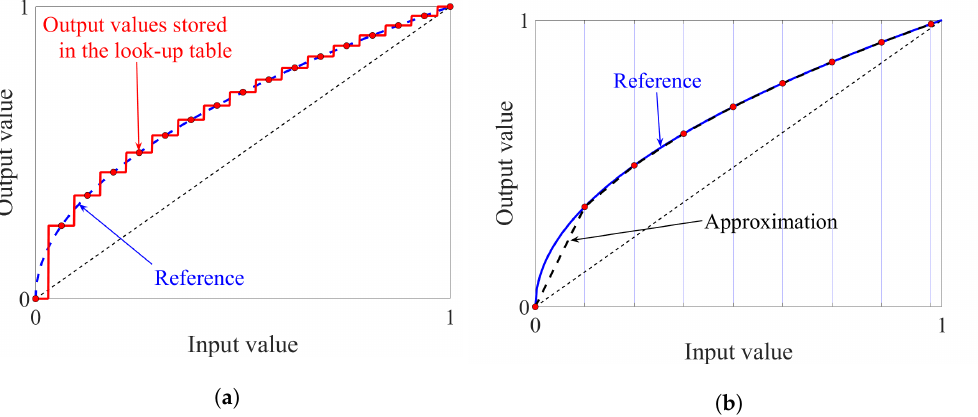
Figure 3. Illustrations of two implementation methods using ( a ) look-up table and ( b ) piece-wise linear polynomial approximation. A gamma value of 0.5 is